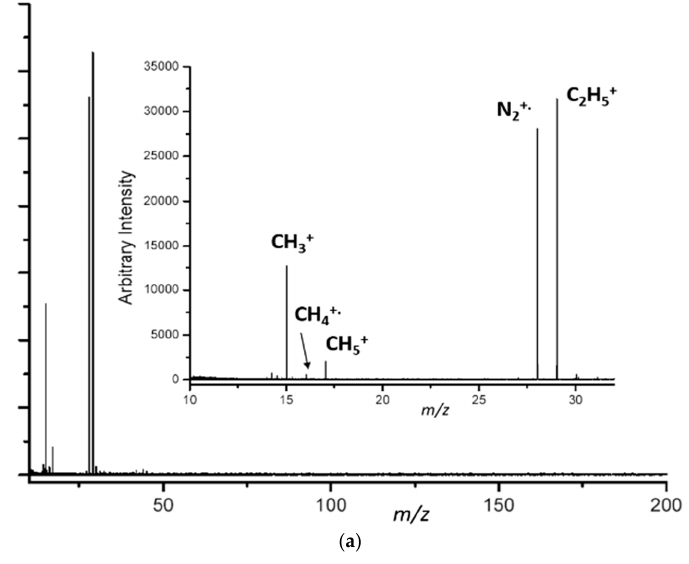
Figure 2. Cont. Figure 2.